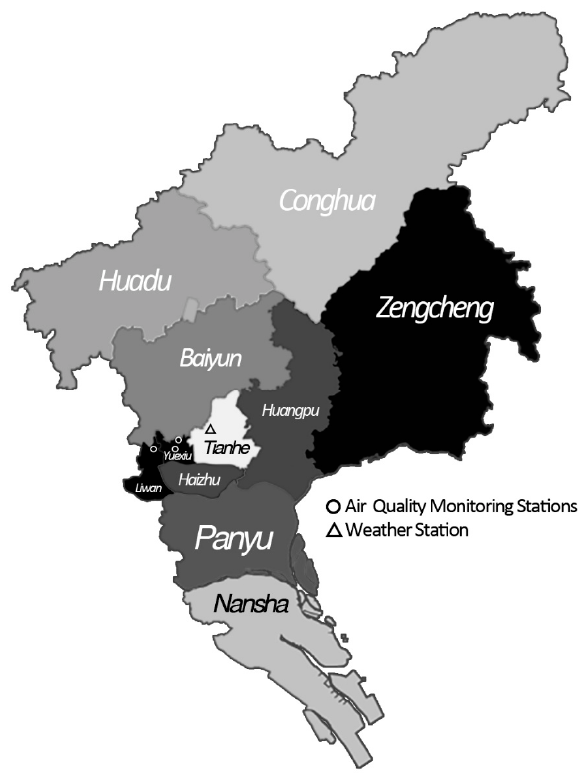
Figure 1. Administrative division of Guangzhou City and the locations of the monitoring stations.